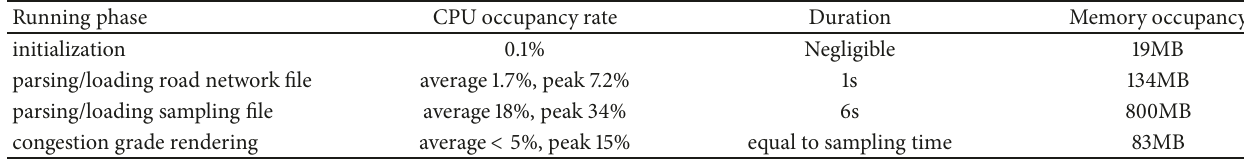
Table 12: Monitoring table of occupying Resources of Cologne Network Operation